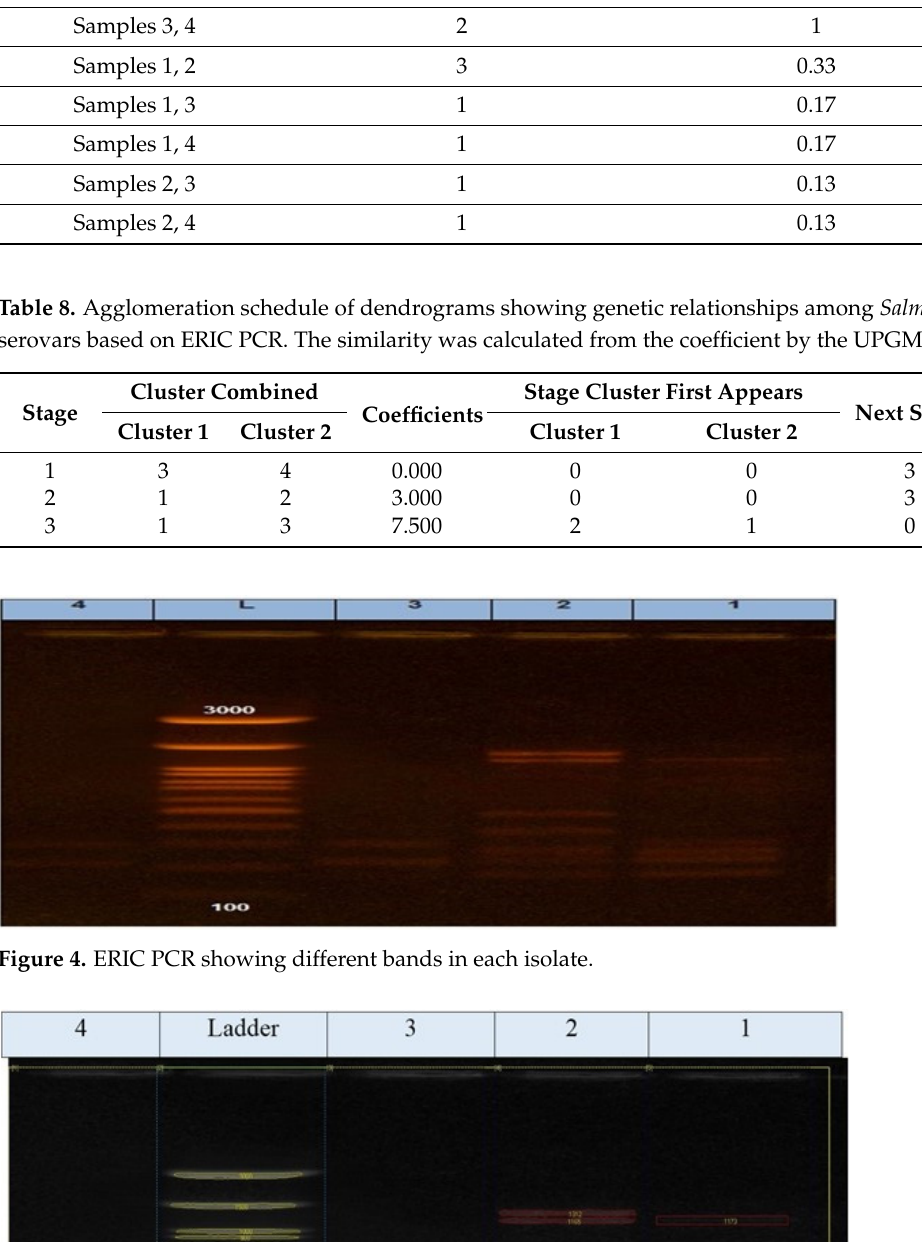
Table 7. The Jaccard/Tanimoto coefficient and the number of intersecting elements for every 2 samples with each other.